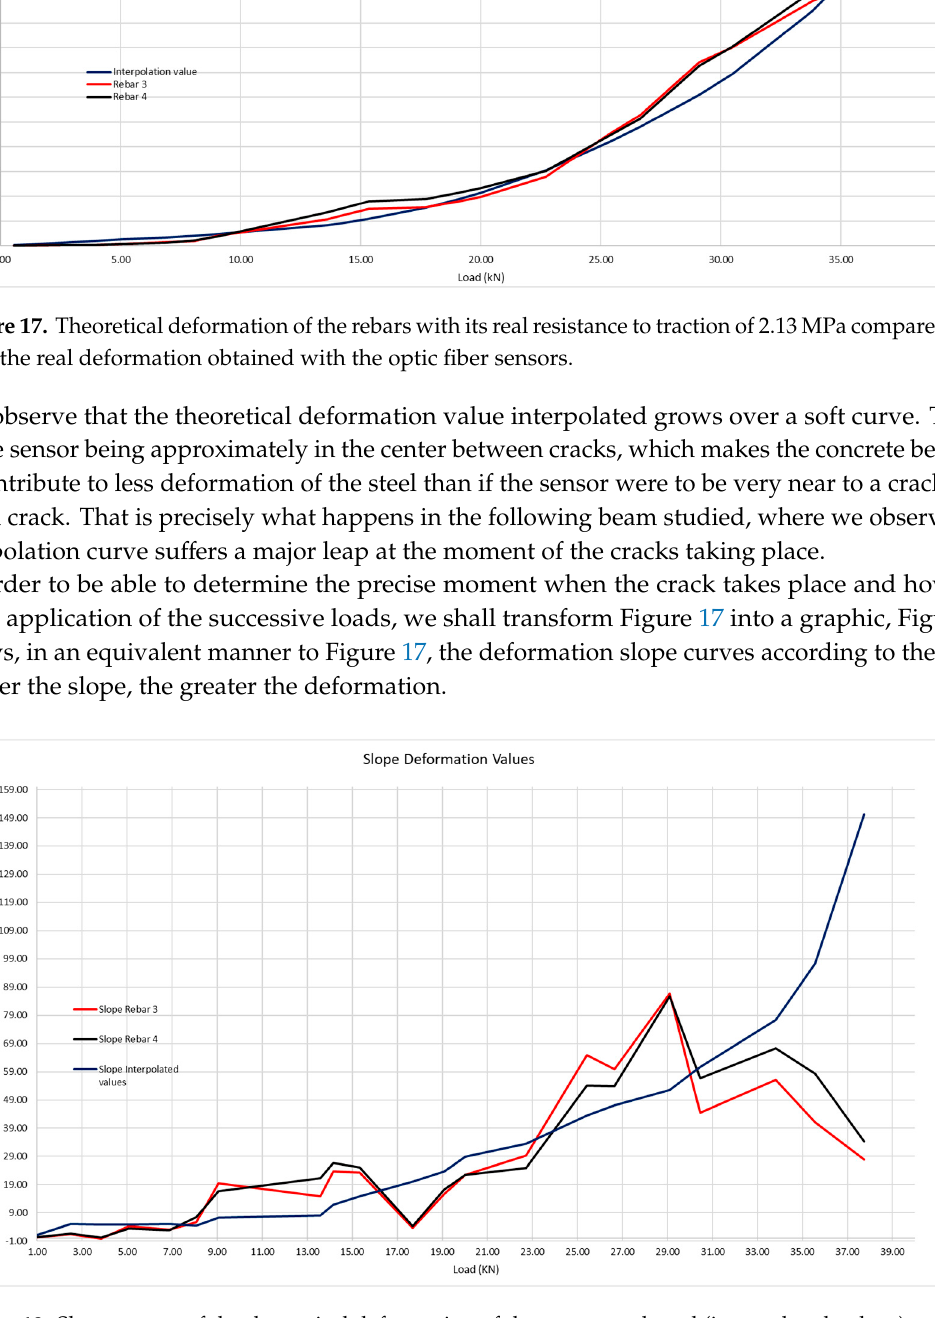
Table 6. Slope values of the theoretical deformation curves and of rebars 3 and 4.